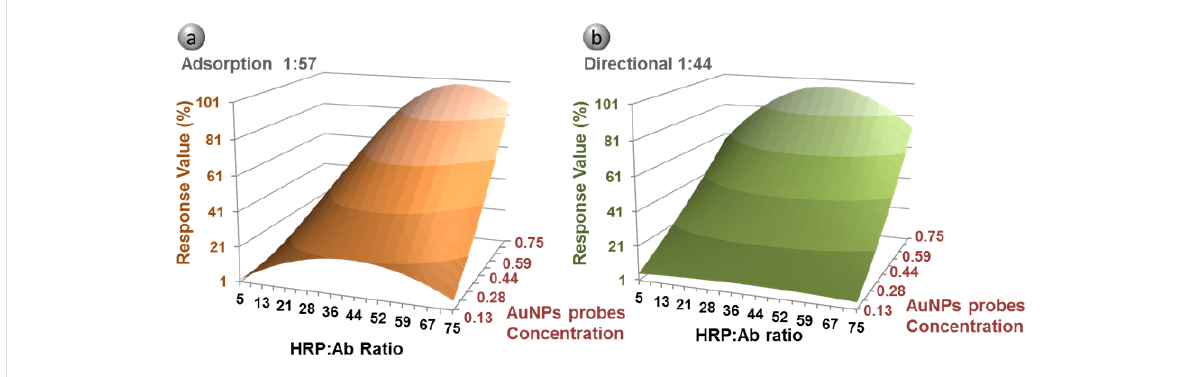
Figure 2: DOE experimental results for adsorption (a) and directional (b) methods. Estimation of the effect on response of HRP/Ab ratio and AuNP probe concentration. The layout displays the response value as percent of the maximal HRP signal at 450 nm. Coefficient of determination of DOE results R 2 = 0.9485 (a) and R 2 = 0.9768